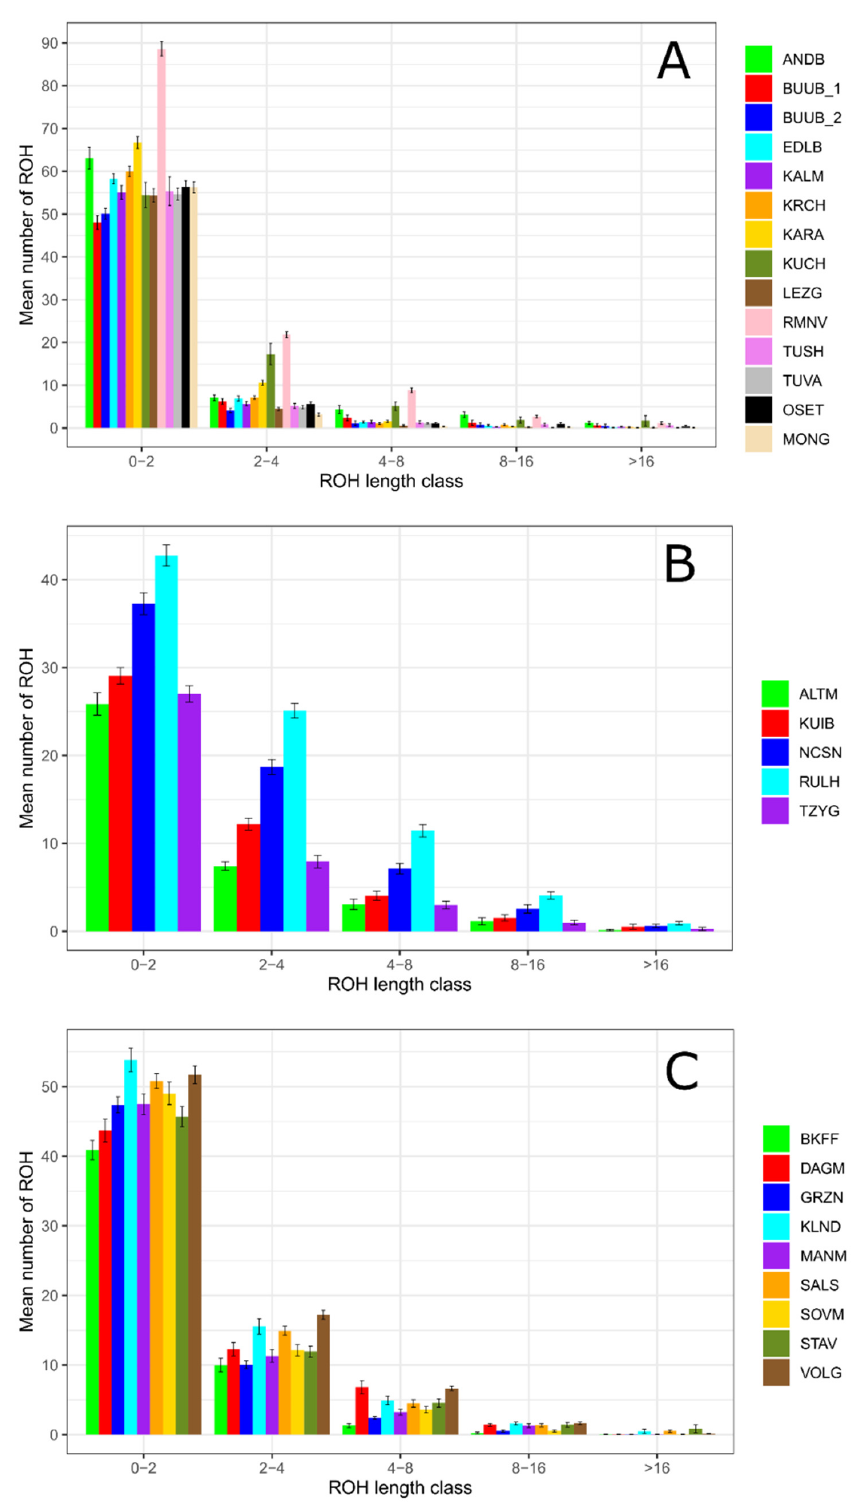
Figure 3. ROH distribution in length classes in Russian sheep populations: ( A ) Mean number of ROH by class within the group of coarse wool breeds; ( B ) Mean number of ROH by class within the group of semi-fine wool breeds; ( C ) Mean number of ROH by class within the group of fine wool breeds. The 2–4 Mb ROH segments were more distributed in semi-fine wool (from 19.73% in the Altai Mountain to 29.76% in the Russian longhaired breeds) and in fine wool